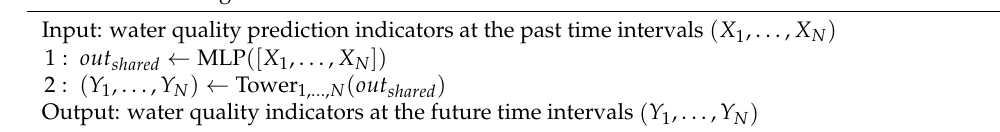
Algorithm 1: Multi-indicator water quality prediction based on hard parameter sharing multi-task learning